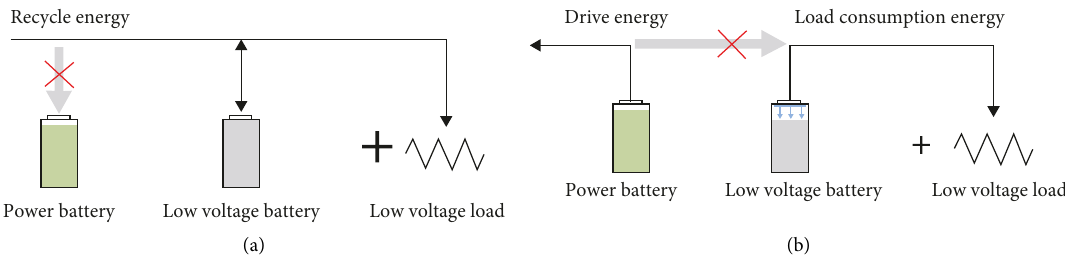
Figure 4: Energy management policy optimization scheme. (a) Energy recovery when the low permitted charge power of power battery. (b) Optimization of low-voltage battery power.